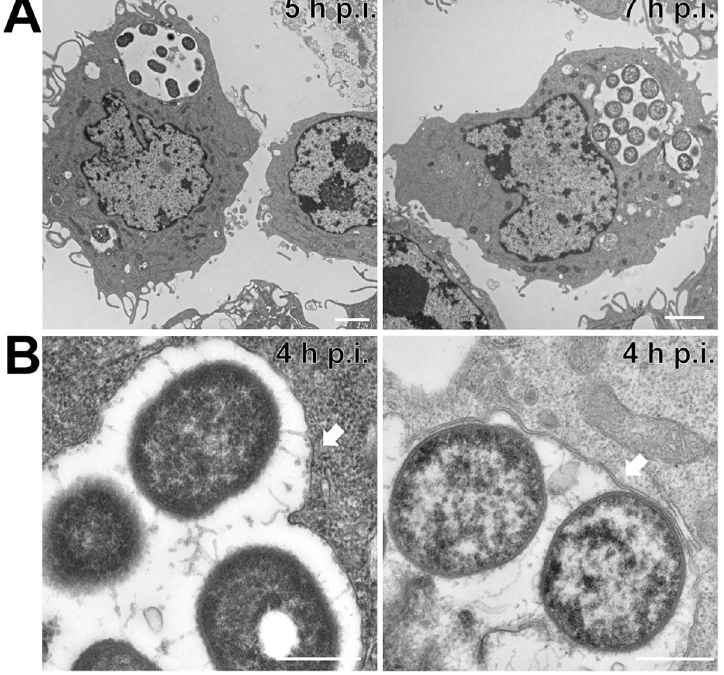
Fig 1. UPAB1 resides in spacious vacuoles within macrophages. Transmission electron microscopic images of J774A.1 macrophages infected with UPAB1 (A) at 5 (left panel) and 7 h p.i. (right panel) Bars: 2 μ m. (B) The UPAB1 containing vacuole can have a single (left panel, white arrow) or double membrane (right panel, white arrow). Bars: 500 nm.